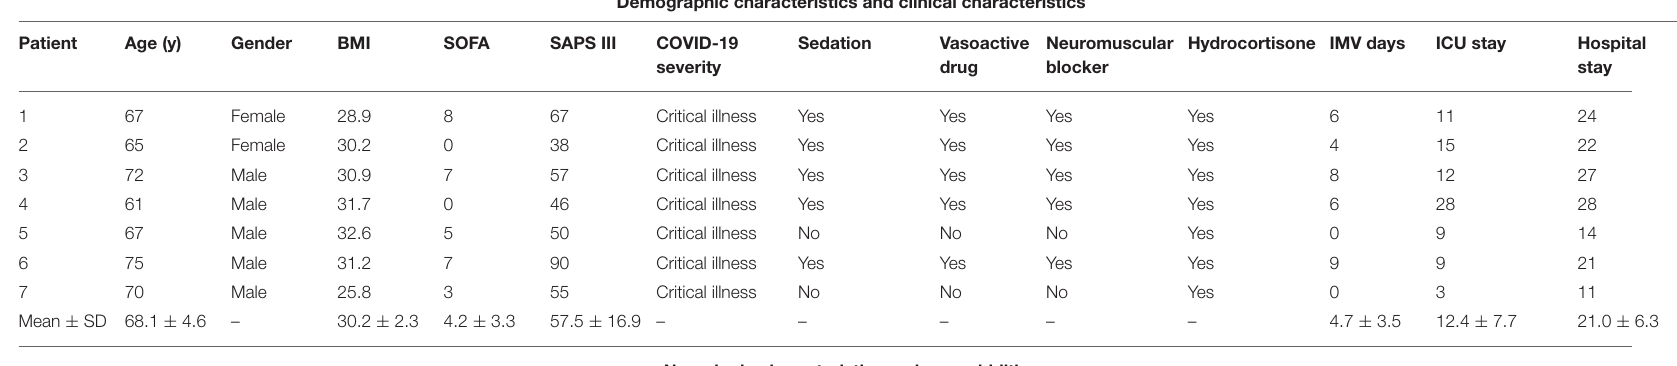
TABLE 1 | Characteristics of patients with COVID-19 associated with sepsis and septic shock during ICU and hospital stay. Demographic characteristics and clinical